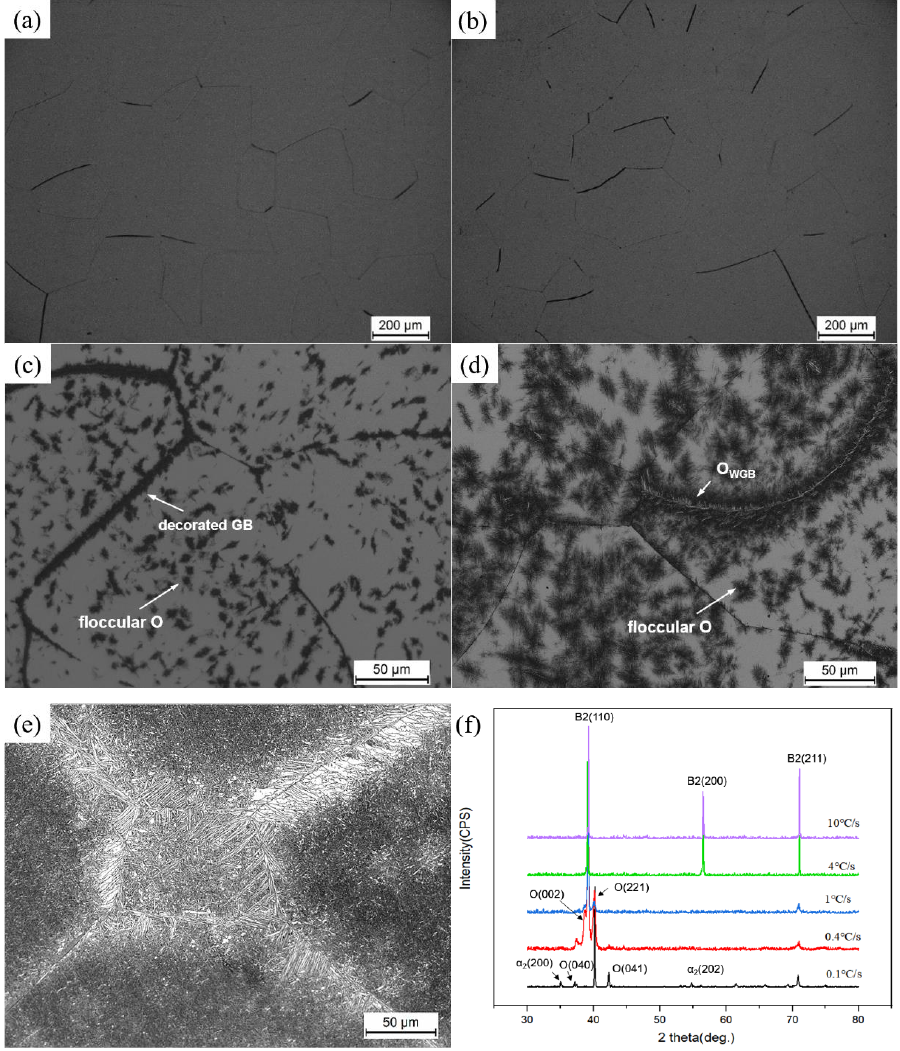
Figure 2. Light microscope images and phase identification of Ti-22Al-25Nb alloy cooled at different rates from 1100 °C: ( a ) 10 °C/s, ( b ) 4 °C/s, ( c ) 1 °C/s, ( d ) 0.4 °C/s, ( e ) 0.1 °C/s, ( f ) XRD pattern.